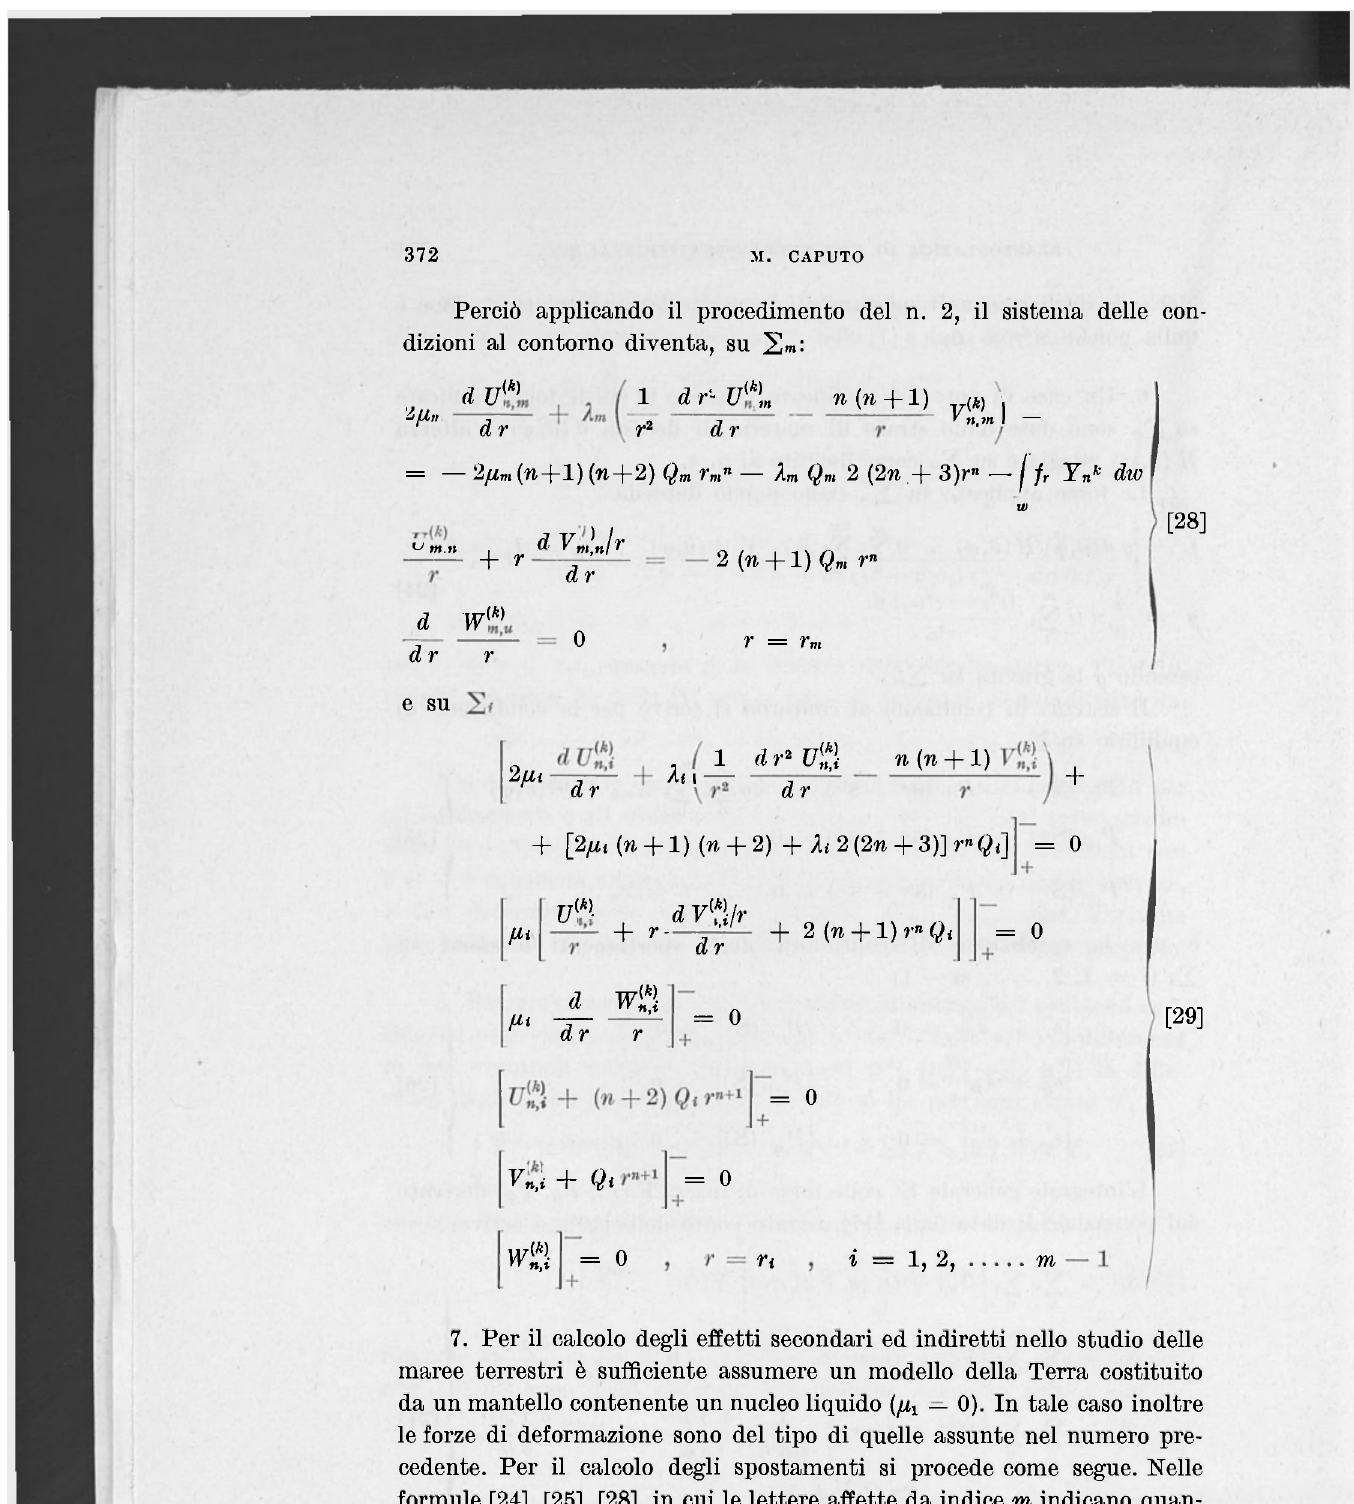
cedente. Per il calcolo degli spostamenti si procede come segue.